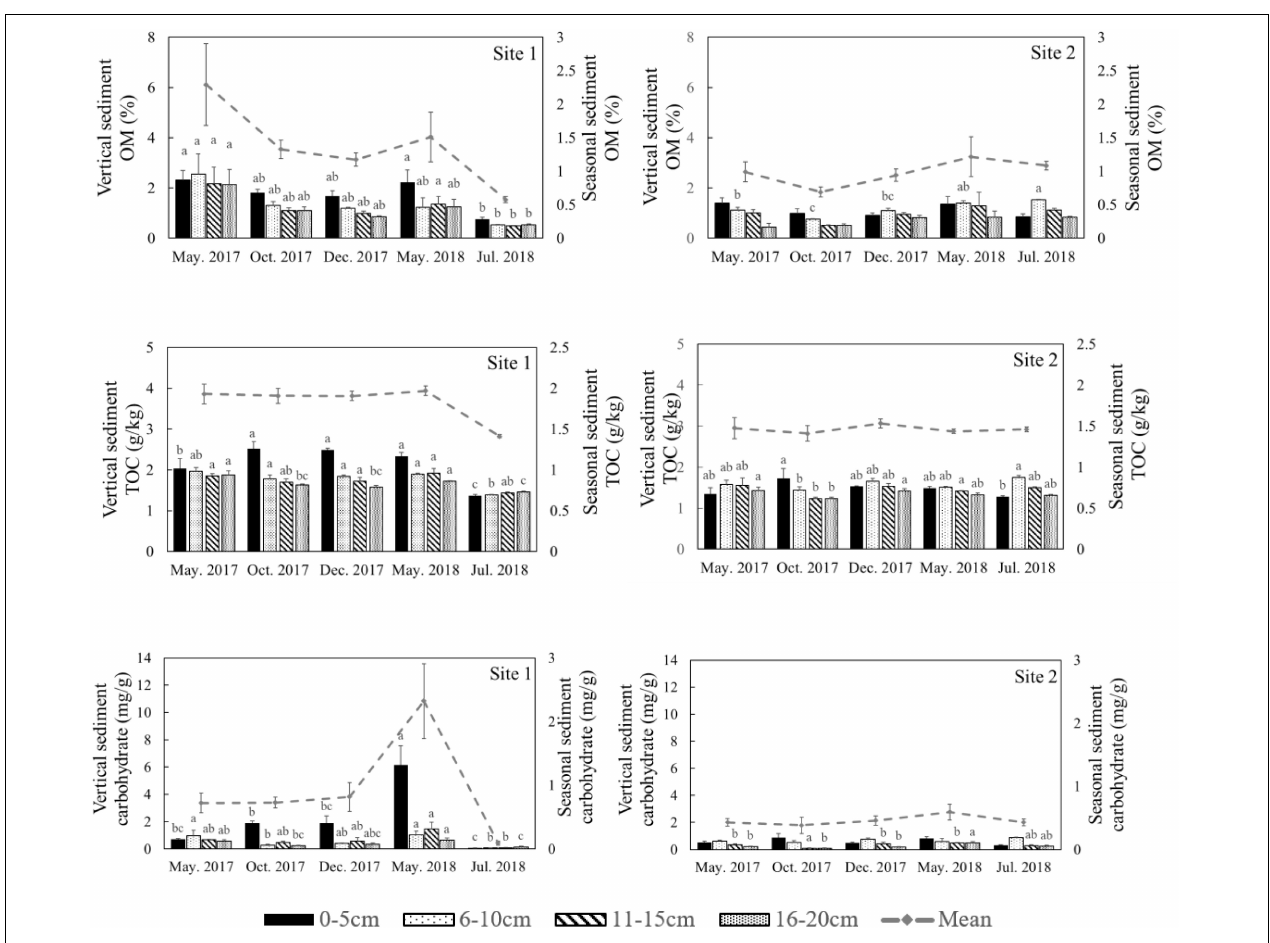
FIGURE 6 | Organic matter (OM), total organic carbon (TOC), and carbohydrate content in different sediment layers in different seasons at the two study sites. The dotted lines represent the seasonal mean values of all parameters. Different letters represent significant differences between different seasons ( p < 0.05).